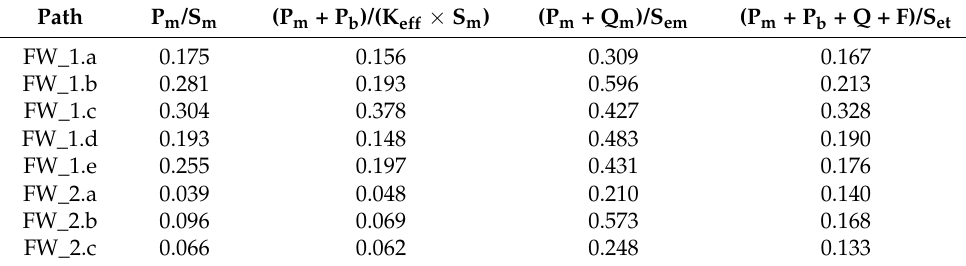
Table 11. RCC-MRx Level A criteria verification within FW-SWs domain.